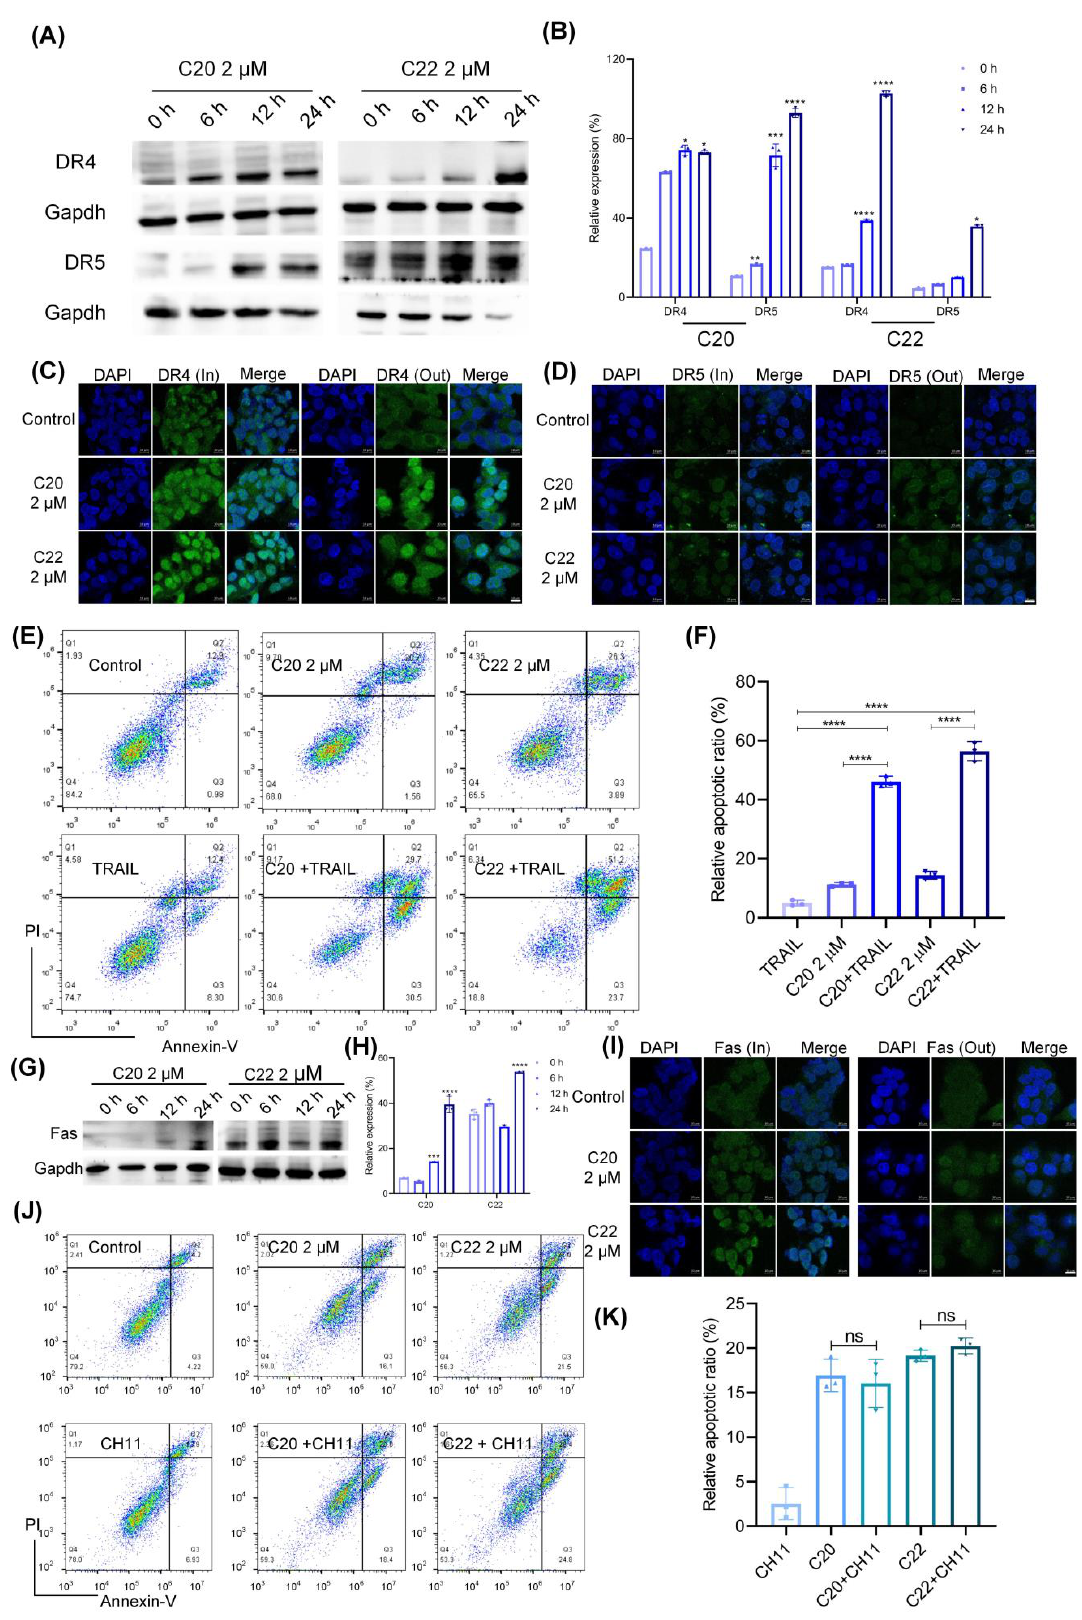
Figure 5. C20/C22 increased the sensitivity of HepG2 cells to TRAIL-induced apoptosis. ( A , B ) WB analysis of the expression of DR4 and 5 in HepG2 cells that were treated with 2 µ M C20/C22 for 0, 6, 12, and 24 h. ImageJ software was used to calculate the gray value ( n = 3). ( C , D ) The